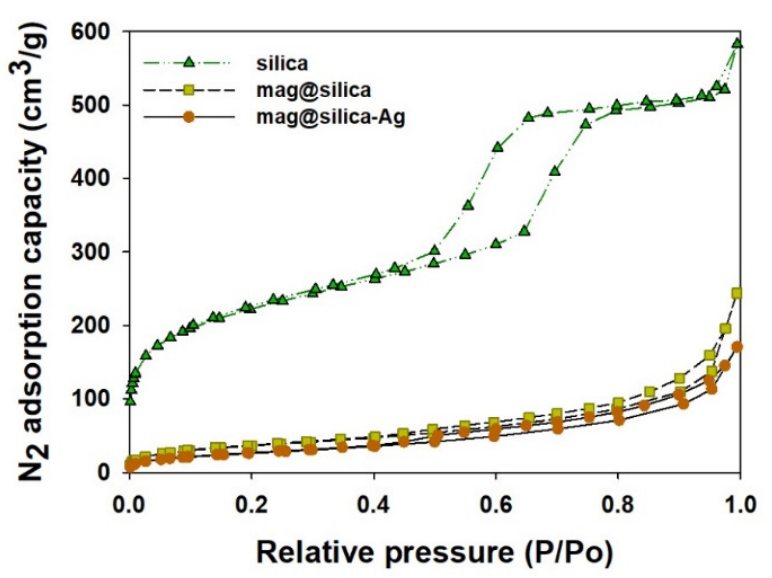
Figure 4. N 2 adsorption-desorption isotherm at 77.3 K on silica, mag@silica, and mag@silica-Ag com- posites. Table 2. Physical properties of the silica, mag@silica, and